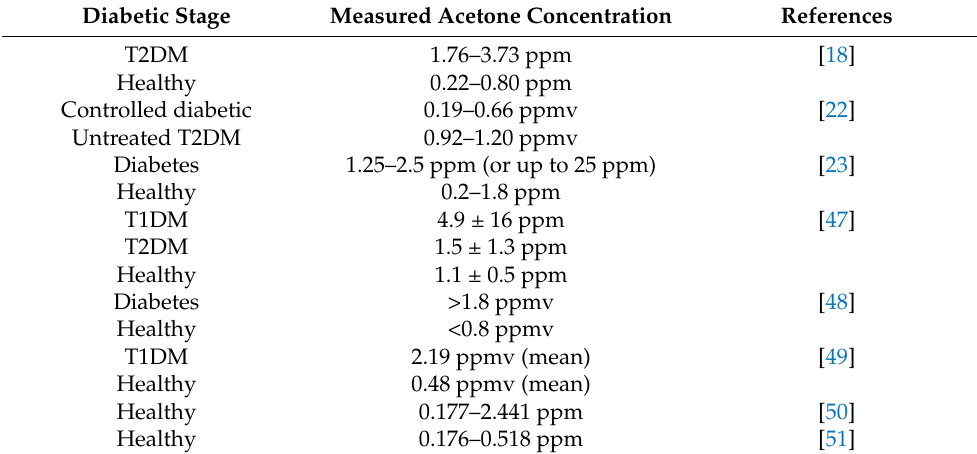
Table 2. Acetone concentration in health and diabetes samples. Diabetic